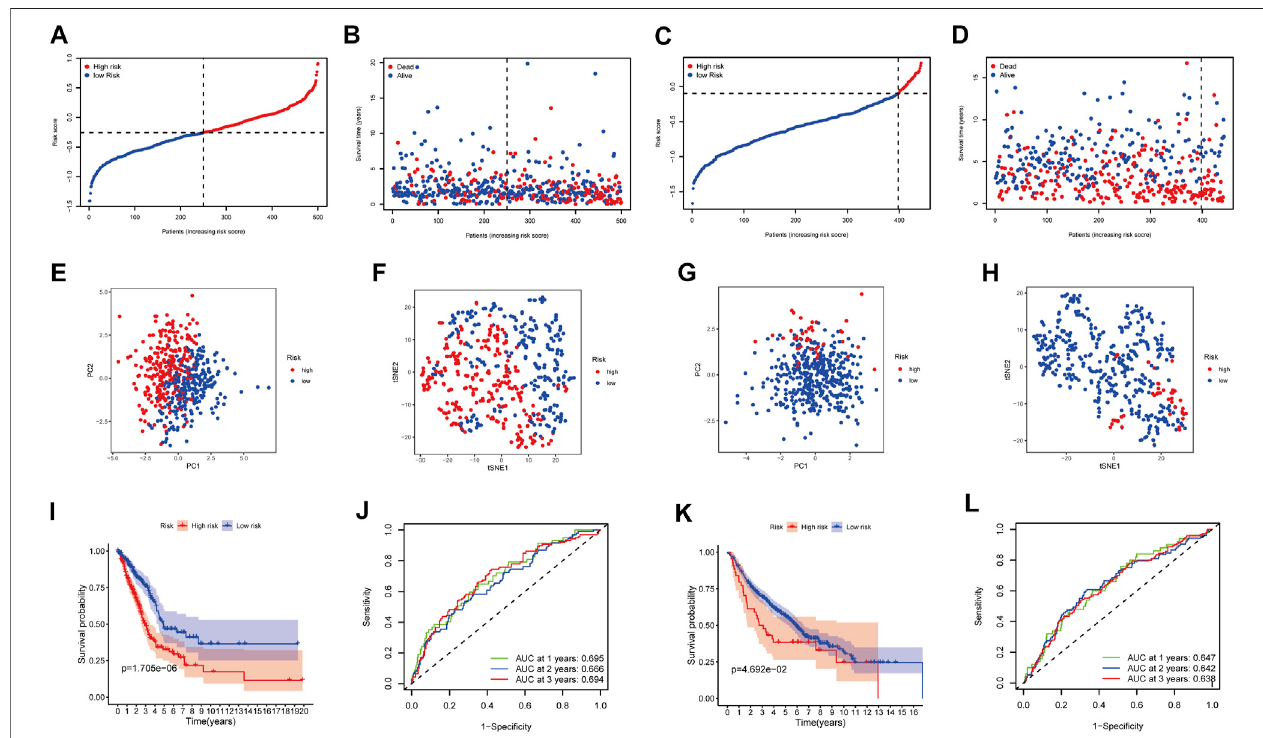
FIGURE3| Prognosticanalysisofthe8-genesignaturemodelintheTCGAcohortandGEOcohort.TCGAcohort (A,B,E,F,I,J) ,GEOcohort (C,D,G,H,K,L) . (A,C) The median value and distribution of the risk scores. (B,D) The distribution of OS status. (E,G) PCA plot. (F,H) t-SNE analysis. (I,K) Kaplan-Meier curves for OS of patients in the high- and low-risk groups. (J,L) AUC time-dependent ROC curves for OS.